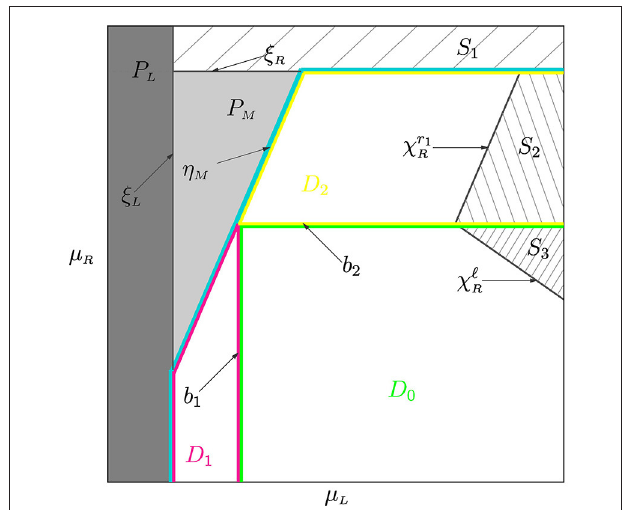
FIGURE 1 | The parameter plane ( µ L , µ R ) of the map f for 0 < a L < 1 and a R > 1. The regions P L , P M are related to stable fixed points. The regions S 1 , S 2 , S 3 are related to diverging orbits. The regions D 1 , D 2 , and D 0 are associated with asymptotic orbits located in I L ∪ I M , I M ∪ I R , and I L ∪ I M ∪ I R , respectively.